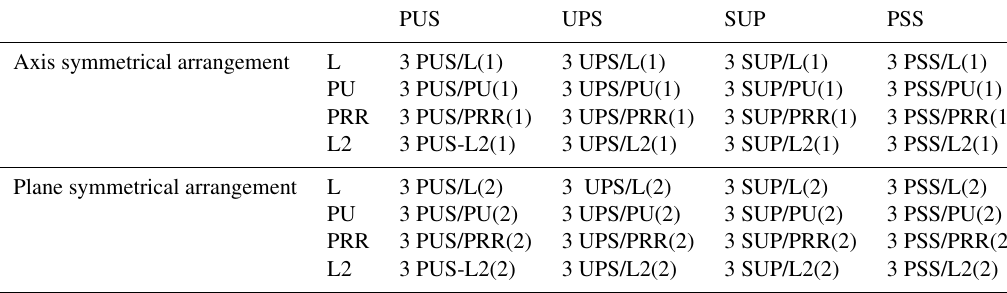
Table 4. Some of the new configurations of compliant parallel